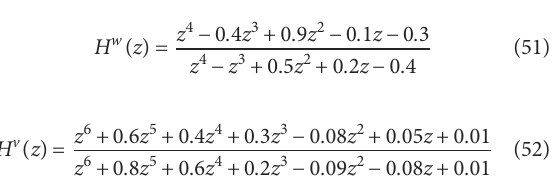
Figure 2 . It can be seen that the CTKF performs better than the TKF. Non-Gaussian noise results in the poor estimation performance of the TKF, since it adopts the MMSE criterion, which uses only second-order statistic of error. The CTKF shows stronger robustness to non-Gaussian noise, because the adopted correntropy cost function can capture second- order and higher-order statistics of error. Simulation